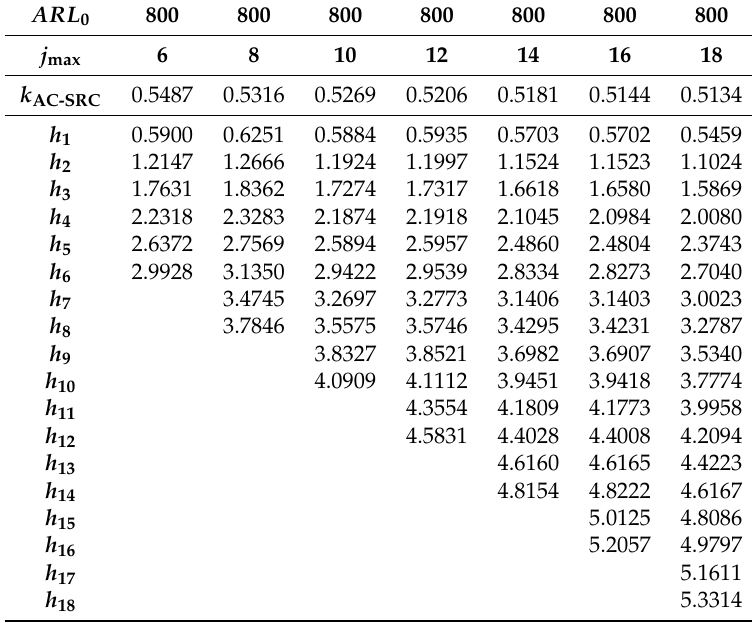
Table A9. AC-SRC for ARL 0 =